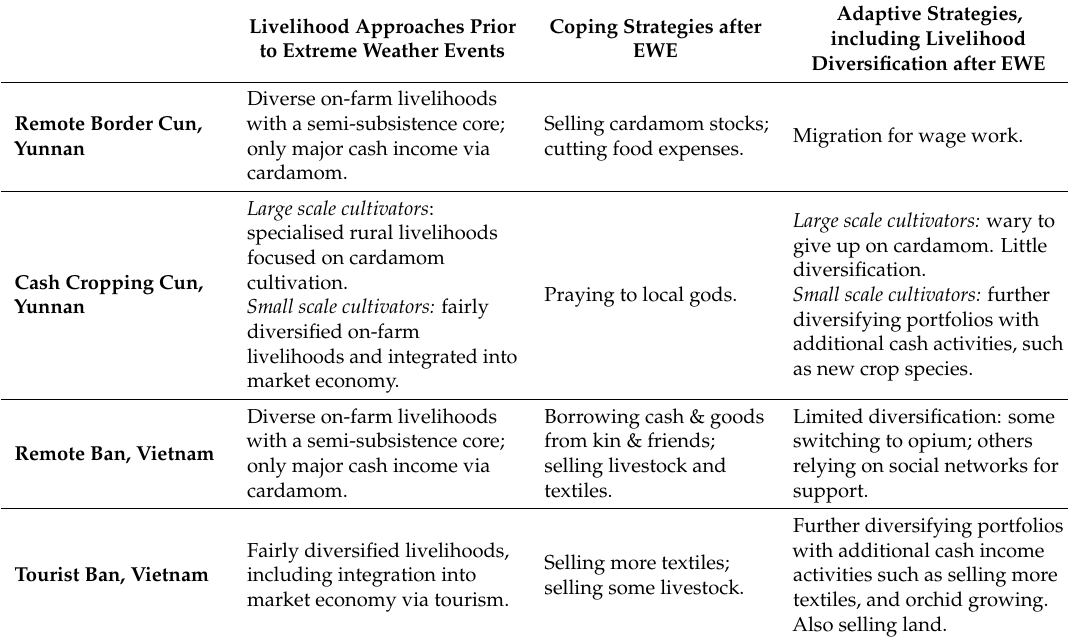
Table 1. Livelihood approaches in the four case study sites prior to extreme weather events (EWE) and cardamom-linked coping and adaptive strategies after